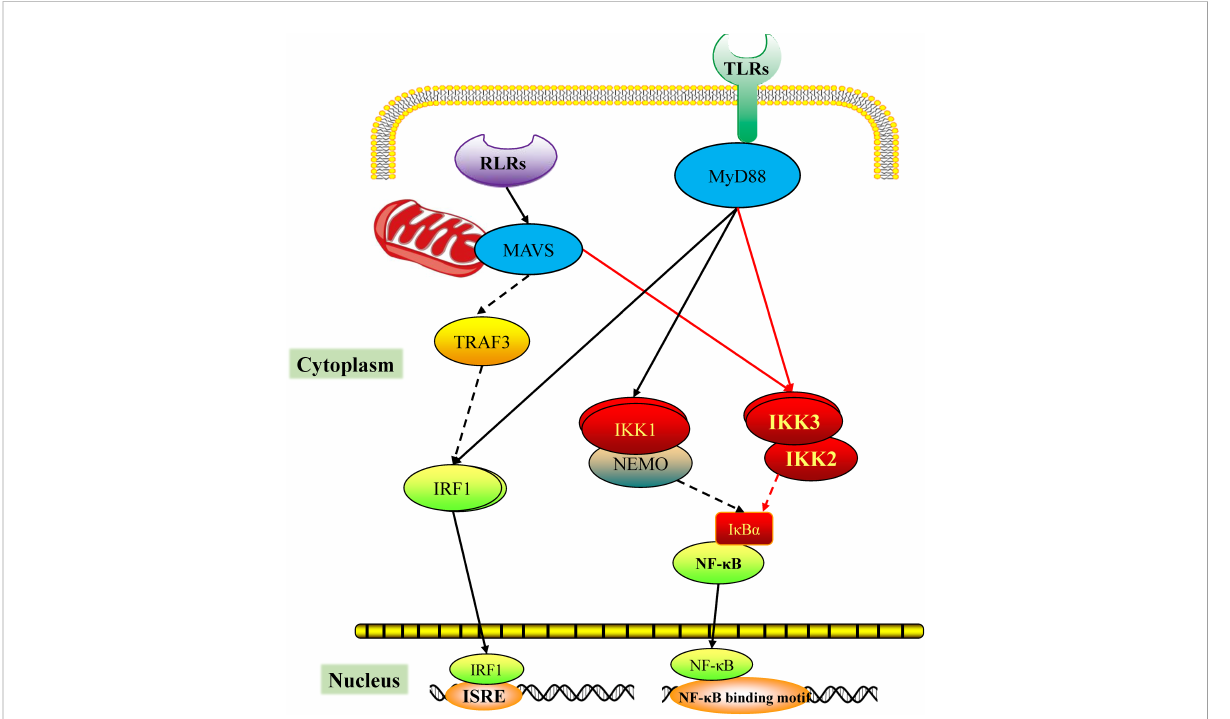
FIGURE 10 Predicted diagram of the scallop the RIG-I-like receptor (RLR) and toll-like receptor (TLR) signaling mediated by CfIKK3. The PAMPs challenge activates the scallop pattern recognition receptors RLR and TLR, which bind the corresponding adaptor molecules CfMAVS or CfMyD88, respectively. Next, CfMAVS and CfMyD88 recruit CfIKK3 for signaling. The dimerization of CfIKK3 and the CfIKK2-CfIKK3 interaction may be crucial steps of IKK complex formation. The IKK complex activates the downstream nuclear factor- k B (NF- k